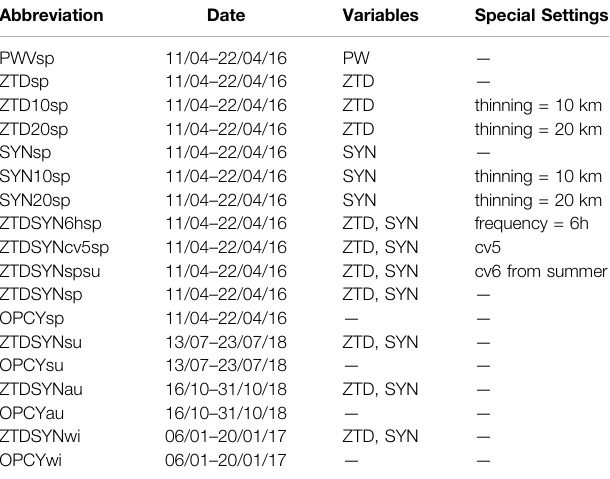
TABLE 3 | Overview of assimilation experiments with abbreviations representing the assimilated observations: e.g., OPCY = open cycle, ZTDSYN = synoptic andZTDdatawiththefollowingadditions: 10 (thinningdistanceof10 km),6 h(6 h cyclingrate), cv5 ( cv5 BEoption), sp , su , au ,and wi (spring,summer,autumn,and winter); additionally, date, assimilation variables and special settings are